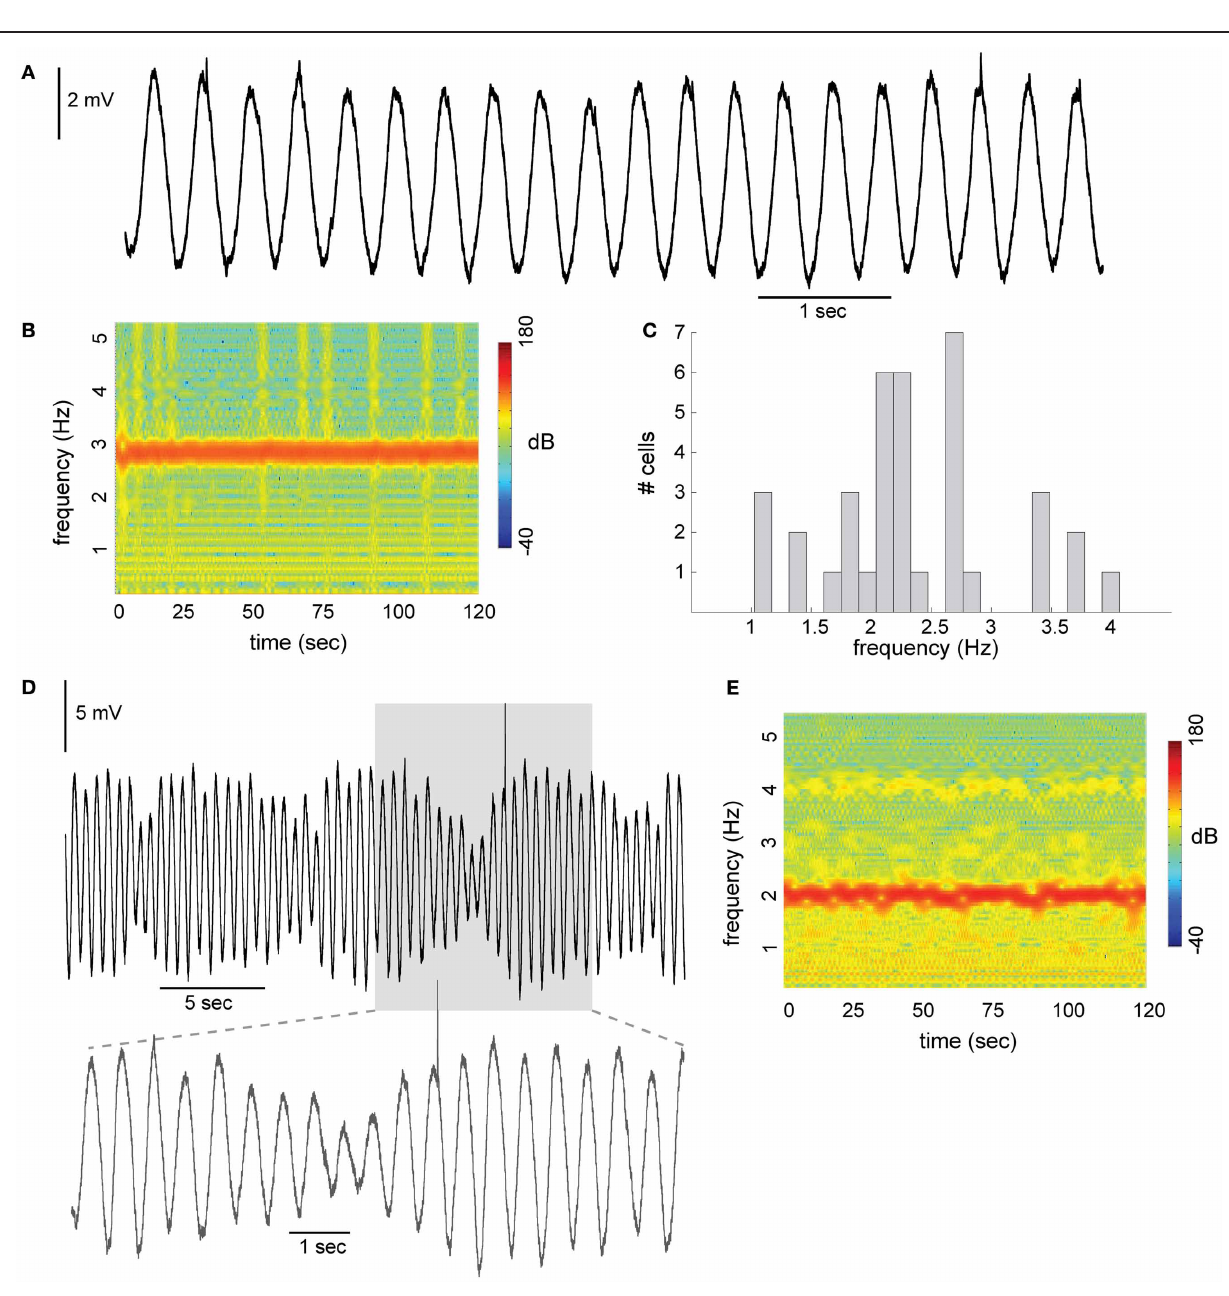
Average frequency was 2.4Hz (histogram bin size is 1/6Hz). (D) STO with amplitude modulation. Prolonged recording, showing the rhythmicity of the amplitude modulation. Lower panel, the gray area in (D) , displayed at faster time scale. (E) Spectrogram of the example shown in (D)